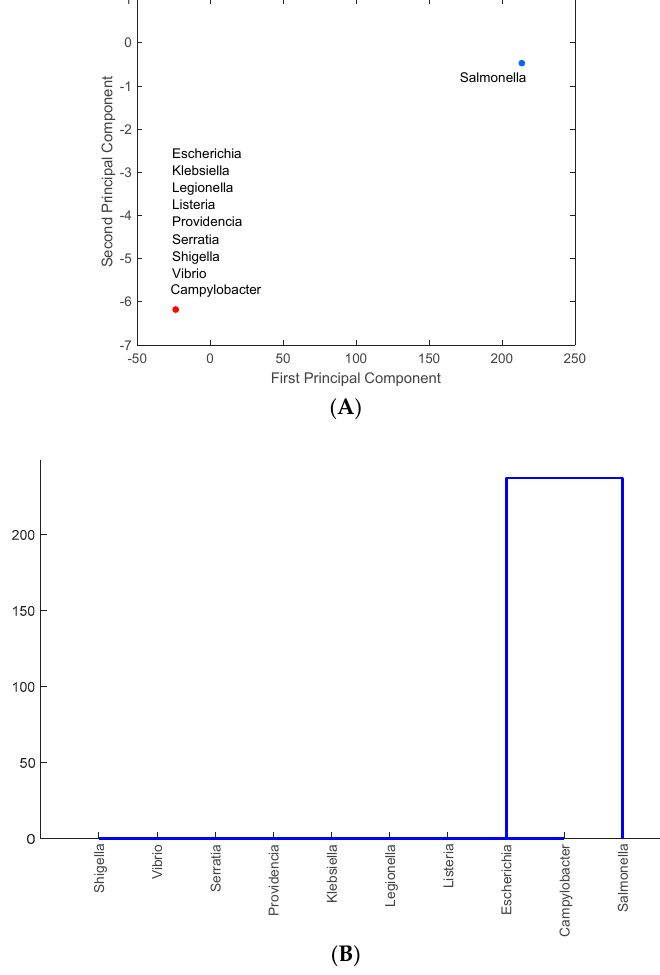
Figure 5. The representation of the major foodborne pathogens that carry antimicrobial-resistance genes in the PC1–PC2 space ( A ) and in the hierarchical clusters ( B ) for Pennsylvania.